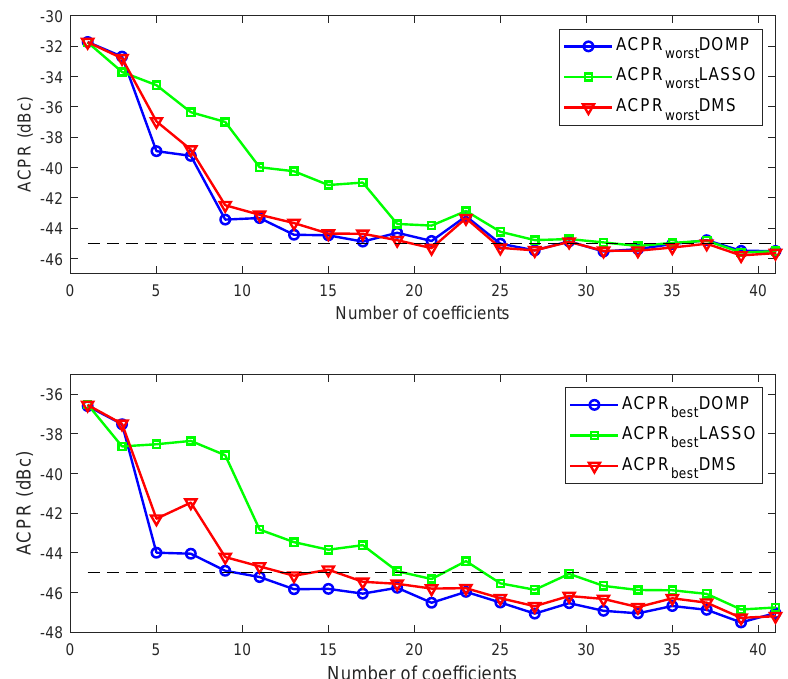
Figure 11. Worst ( top ) and best ( bottom ) ACPR versus the number of coefficients when considering DOMP, DMS and LASSO feature selection techniques.